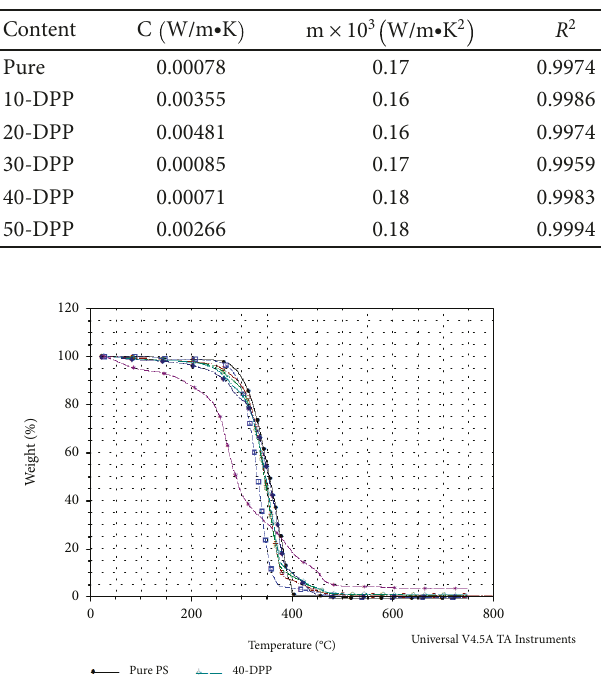
Figure 9: Thermal conductivity of composites at di ff erent temperatures. Table 2: Parameters of equation 8 as a function of fi ller content.